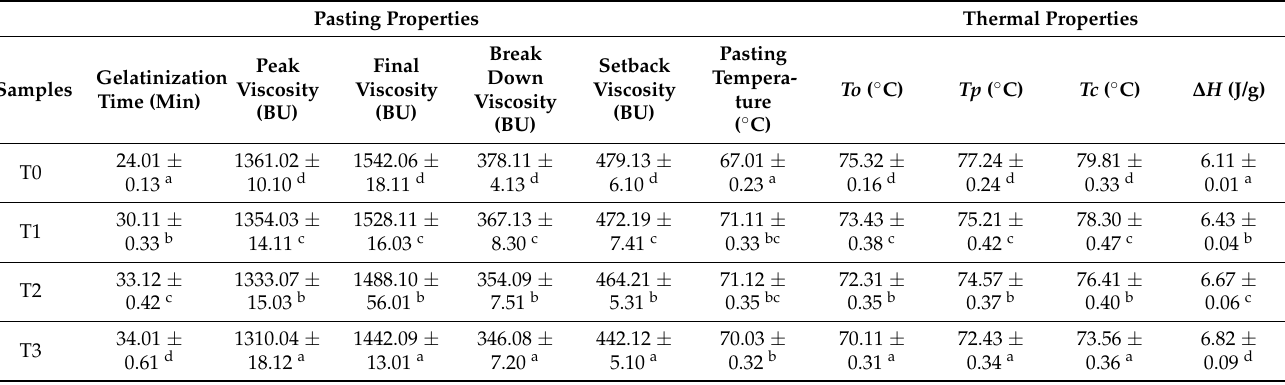
Table 3. Pasting properties of rice flour and different ratios of date pit flour (DPF) and Assyrian plum flour (APF) incorporated in rice